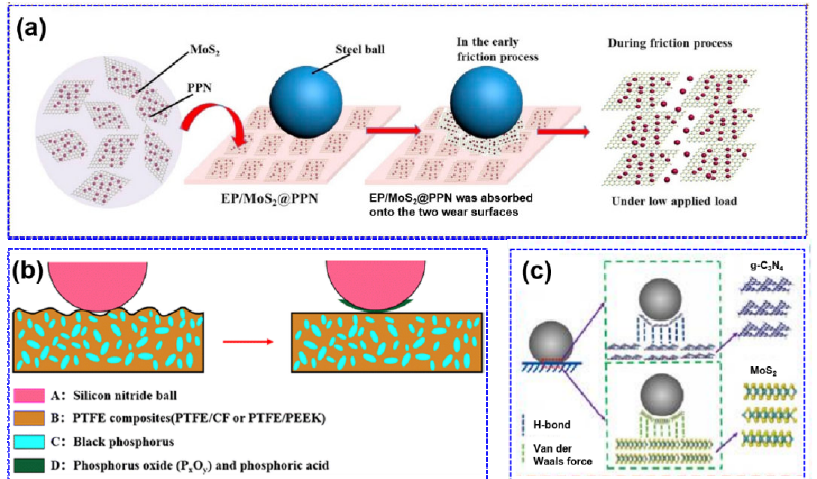
Fig. 8 Schematic of friction mechanism for (a) EP/MoS 2 @ PPN composites. Reproduced with permission from Ref. [154], © Elsevier Ltd. 2018. (b) PTFE/phosphorene. Reproduced with permission from Ref. [150], © Springer Nature 2018. (c) PTFE/MoS 2 and PTFE/g-C 3 N 4 . Reproduced with permission from Ref. [149], © Springer Nature 2019. discussed in the following